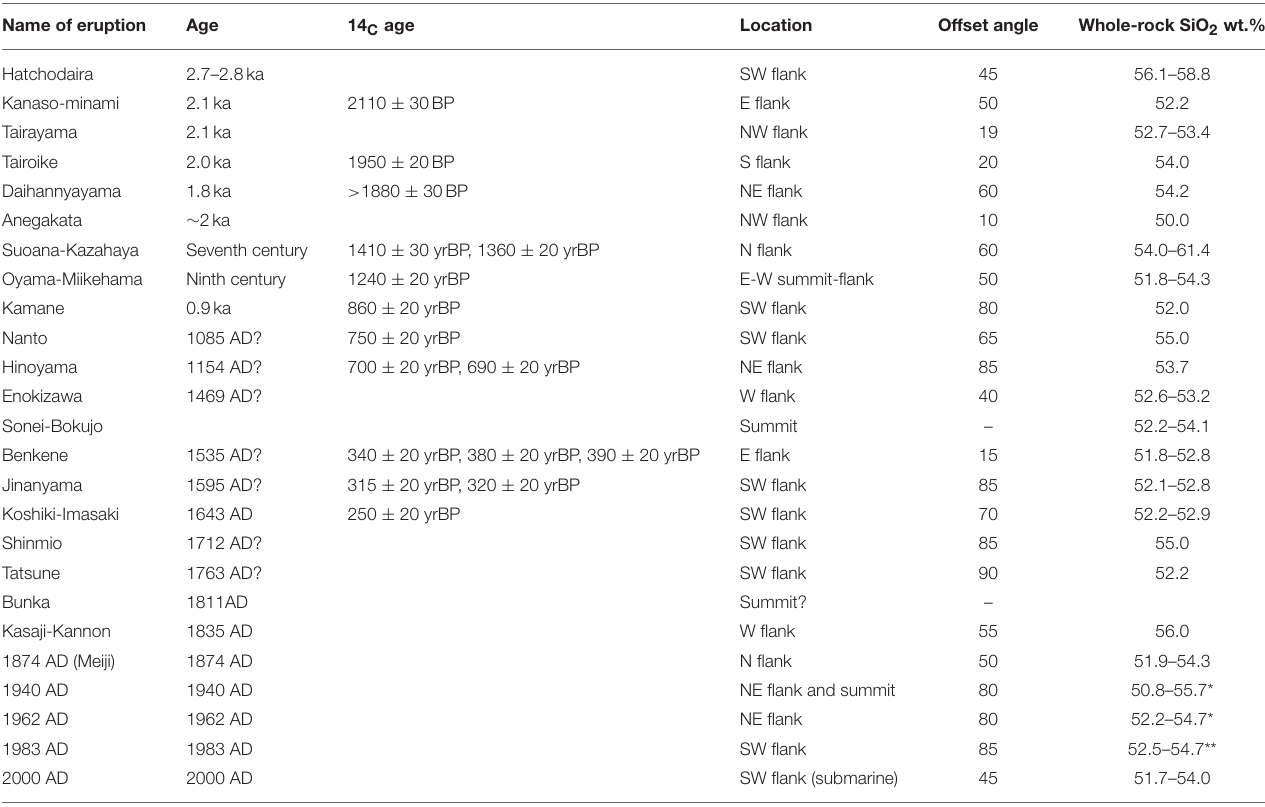
TABLE 1 | Age, offset angle, and whole-rock composition of fissure eruptions. Name of